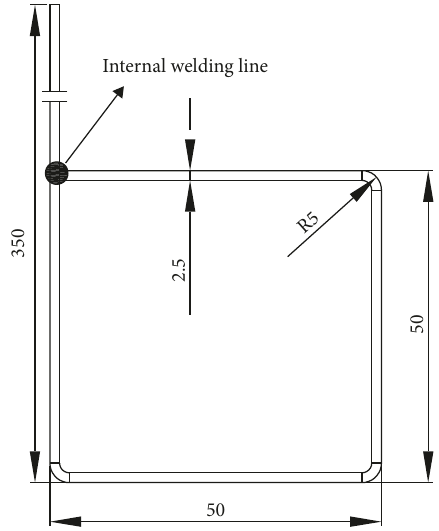
Figure 6: Section size of b-shaped tube.